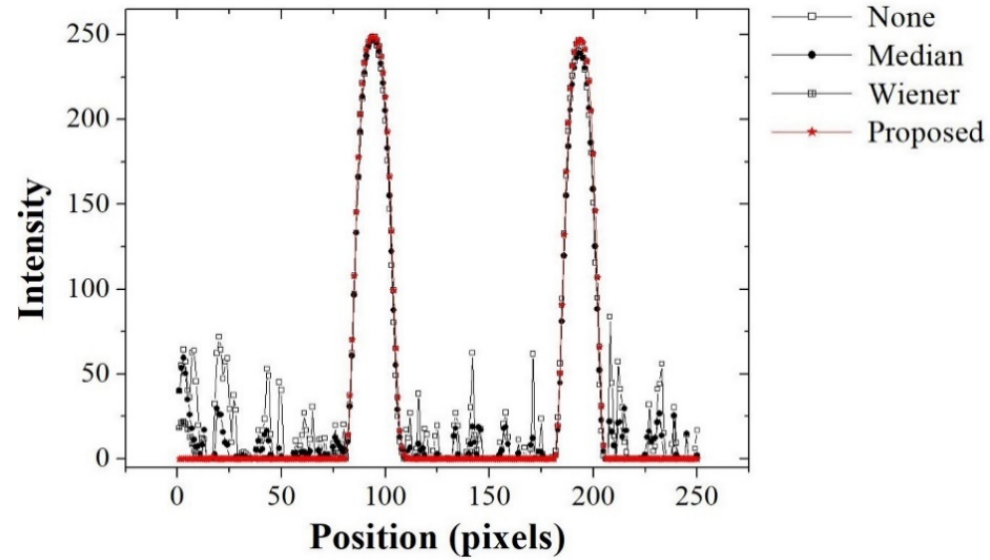
Figure 6. Intensity profiles (for line AB in Figure 5) for different smoothing methods applied to the acquired NIR image.